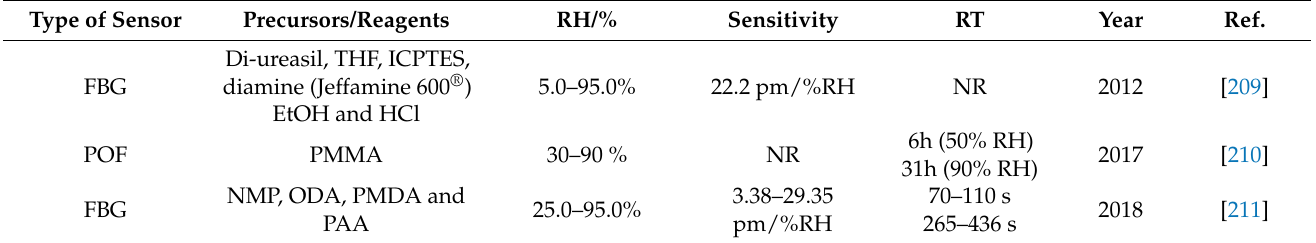
Table 4. Some sensors for moisture monitoring reported in recent